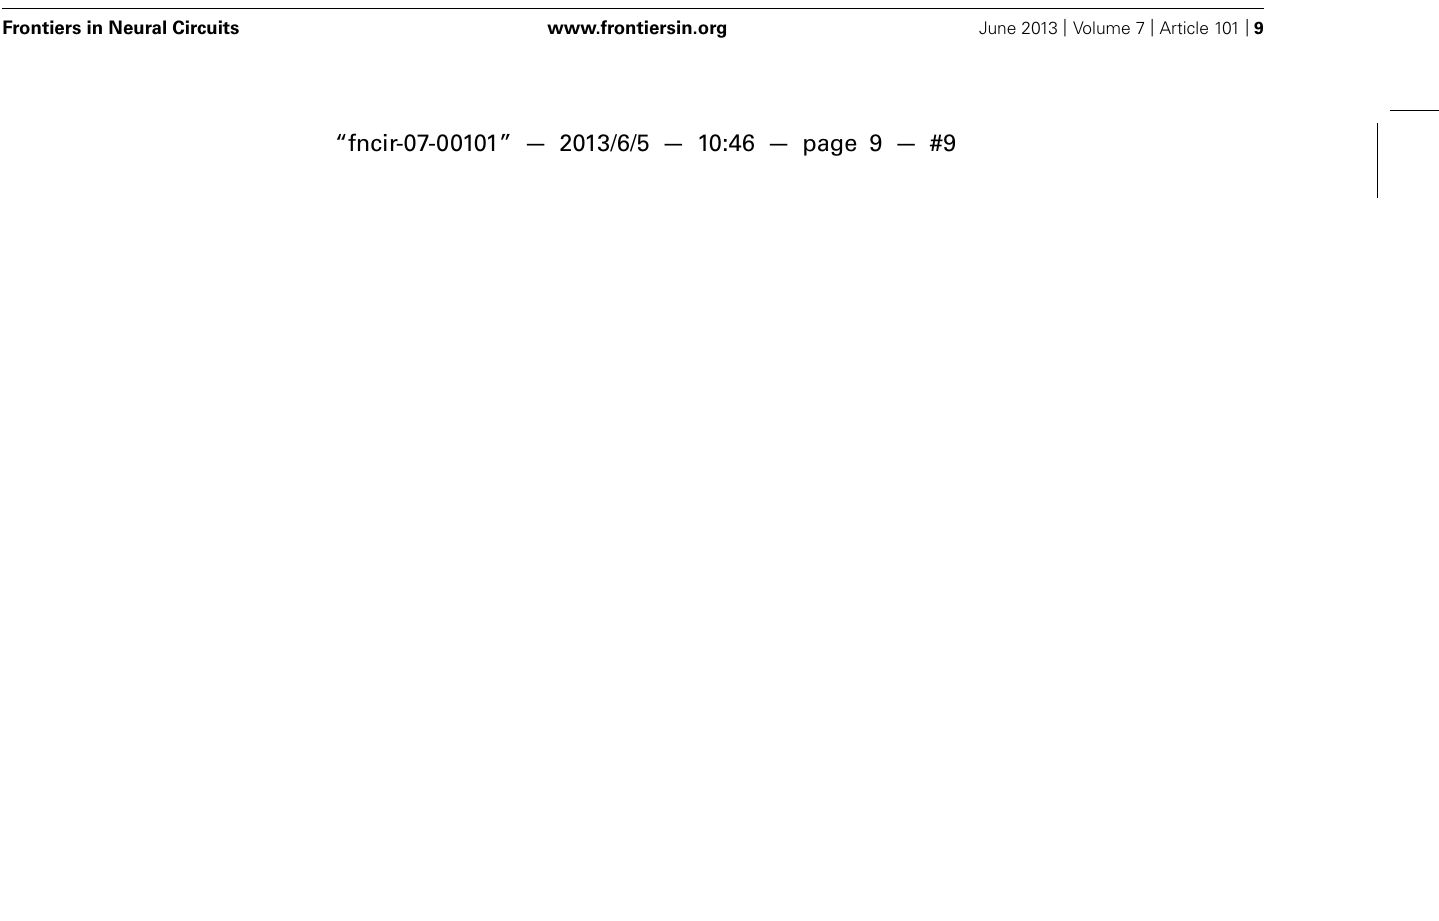
FIGURE 4 | Example of continuous parameter confounding in a simple non-linear neural network model. Adapted with permission from DiMattina and Zhang (2010). (A) A simple three layer neural network whose input and output weight parameters ( w , v ) we wish to estimate from noisy stimulus–response data. Noise is drawn from a Poisson distribution. (B) Top : The input stimuli x ∈ [ − 0.5, 0.5] only drive the hidden unit over a limited region of its gain function (black curve) which may be well approximated by a